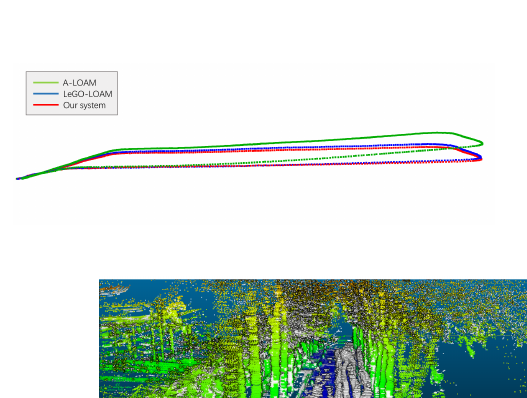
Figure 7. Translation difference of playground . Two revisited places are circled in orange in the trajectory and marked by different colors in the chart with parrallel dotted lines showing the discrepancies.